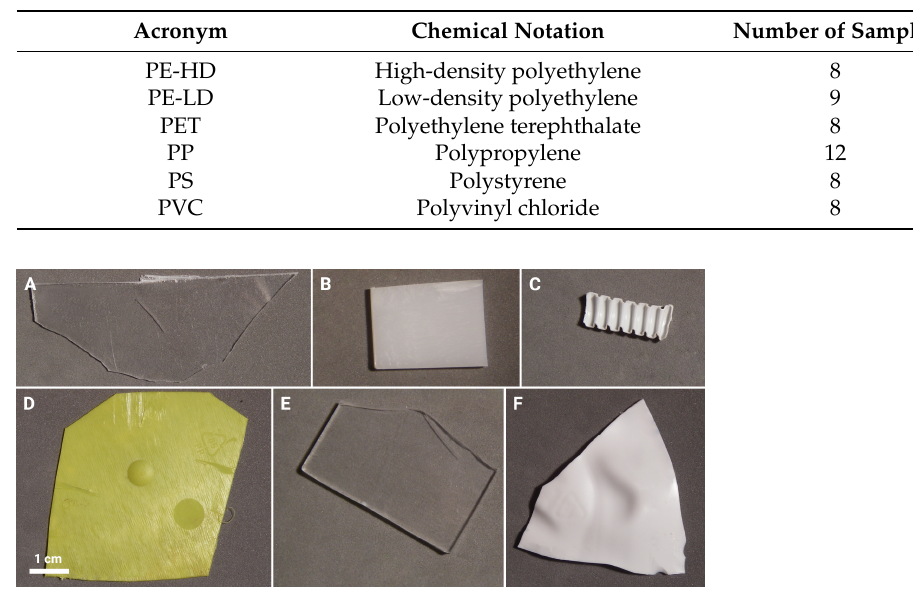
Table 1. Plastic types used for the spectral database. In total, we used 53 samples of 6 different types, while we handled PE-HD and PE-LD as one plastic type, i.e., PE.